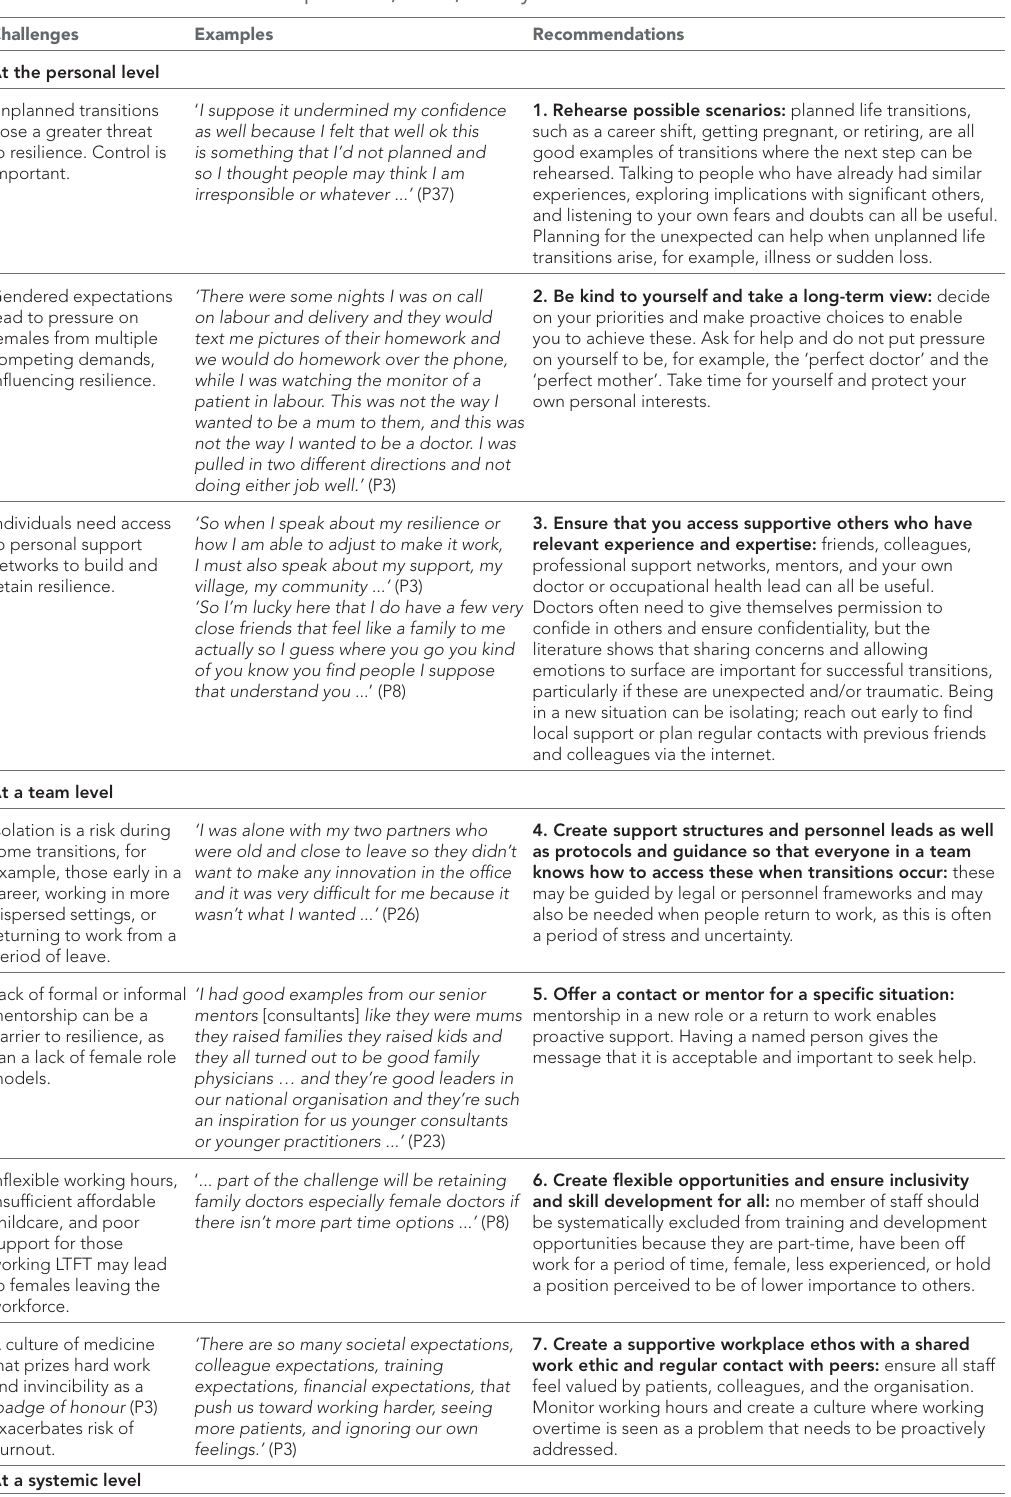
Table 3 A summary of the major challenges to the resilience of female family doctors and